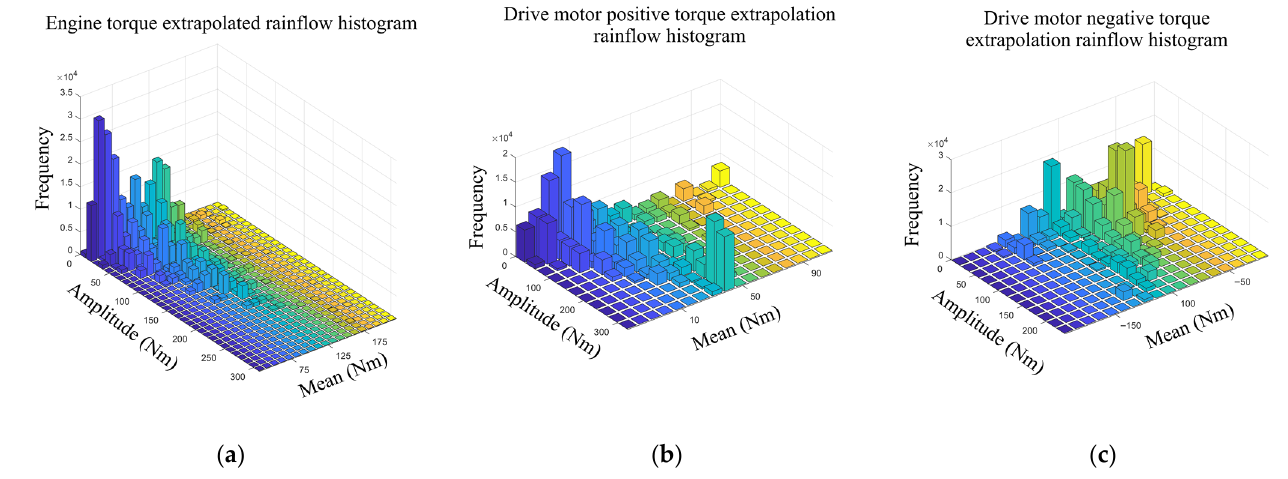
Figure 6. Torque extrapolation rain flow matrix of each power source under urban working conditions: ( a ) engine torque extrapolation rainflow matrix, ( b ) drive motor positive torque rainflow matrix, ( c ) drive motor negative torque rainflow matrix.